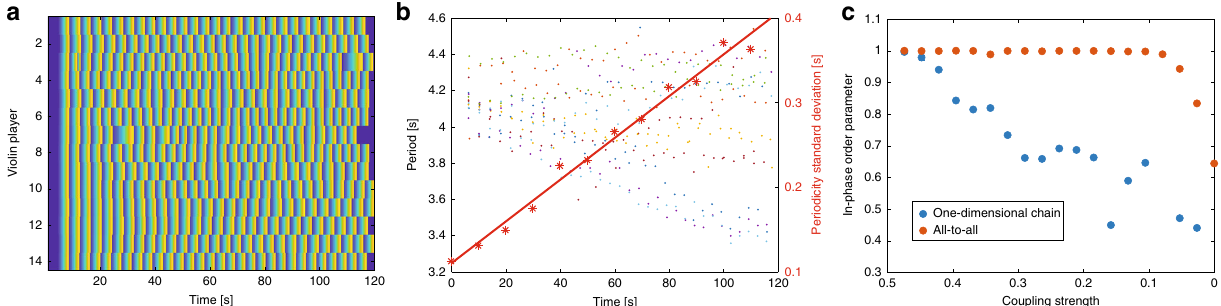
Fig. 2 Uncoupled and coupled violin players in different con fi gurations. Here we show the playing period and the phase of each player as a function of time and the in-phase order parameter as a function of the coupling strength for different con fi gurations. The playing period of each player denotes the time that it takes for each player to play the entire musical phrase, and the phase denotes where in the musical phrase the player is at a speci fi c time. a The phase of each violin player as a function of time without coupling, where blue denotes the beginning of the musical phrase and yellow denotes the end. b The playing period of each player (color dots) and the standard deviation of the period (asterisks) with a fi tted linear curve as a function of time without coupling, showing that with no coupling, each player is changing its playing period without any correlation to other players. c The in-phase order parameter of the network as a function of the coupling strength for two different con fi gurations: one-dimensional chain with nearest-neighbor coupling and a global all-to-all coupling.